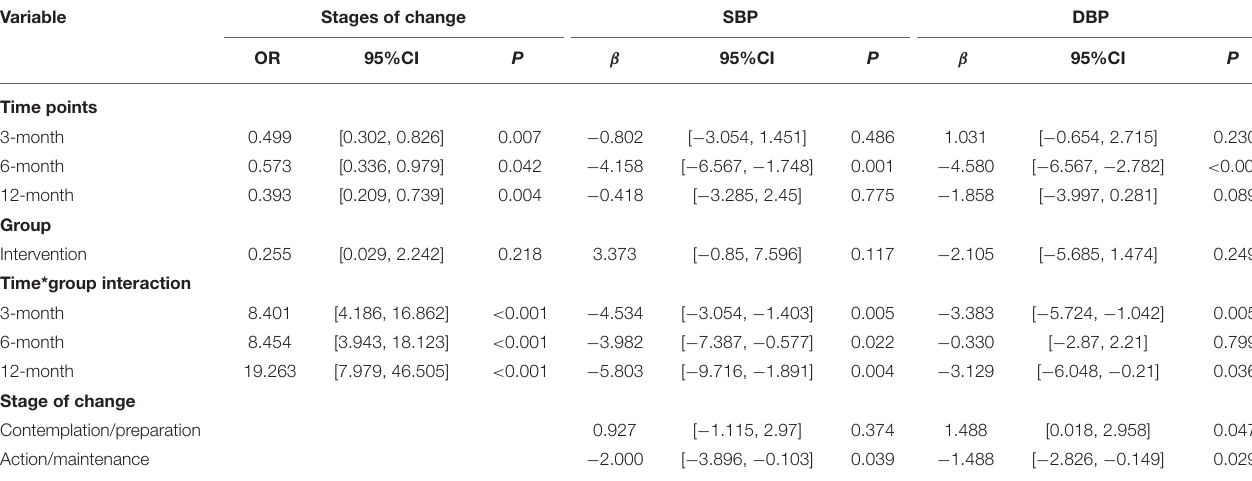
TABLE 4 | Effects of TTM-based intervention on stage of change, systolic blood pressure, and diastolic blood pressure.